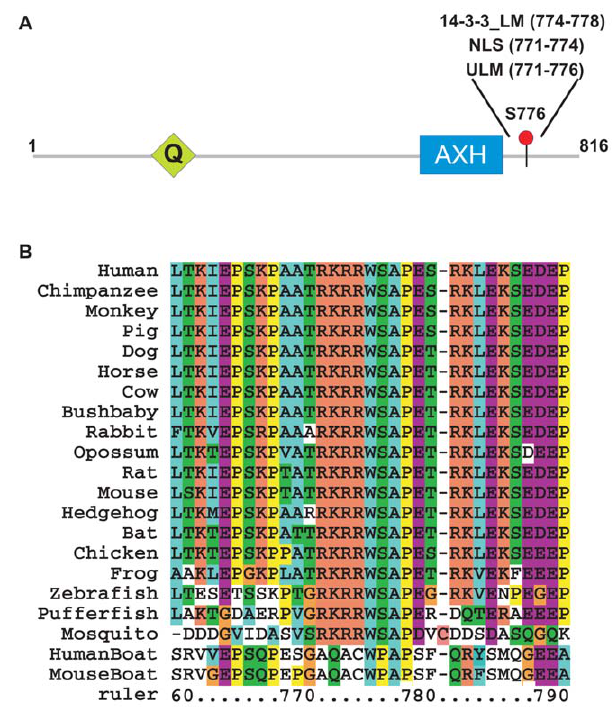
Figure 1. Sequence analysis. A. Schematic representation of the Atx1 architecture. The positions of the polyQ tract (Q) and of the AXH motif are indicated as well as S776. B. Alignment of the ULM motif in Atx1 orthologs and of the corresponding Boat sequences. The alignment was coloured according to standard coding. Sequence numbering follows human